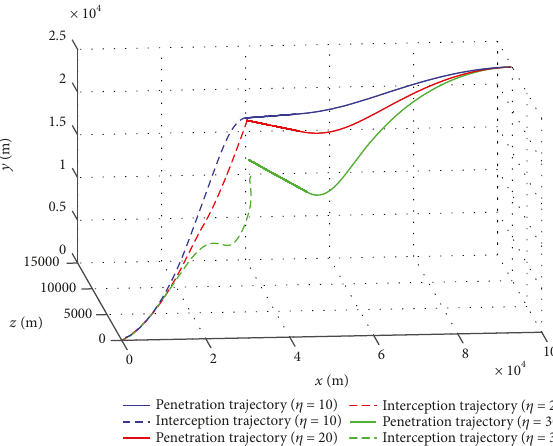
Figure 9: The attack and defense trajectories in the scenario of no terminal